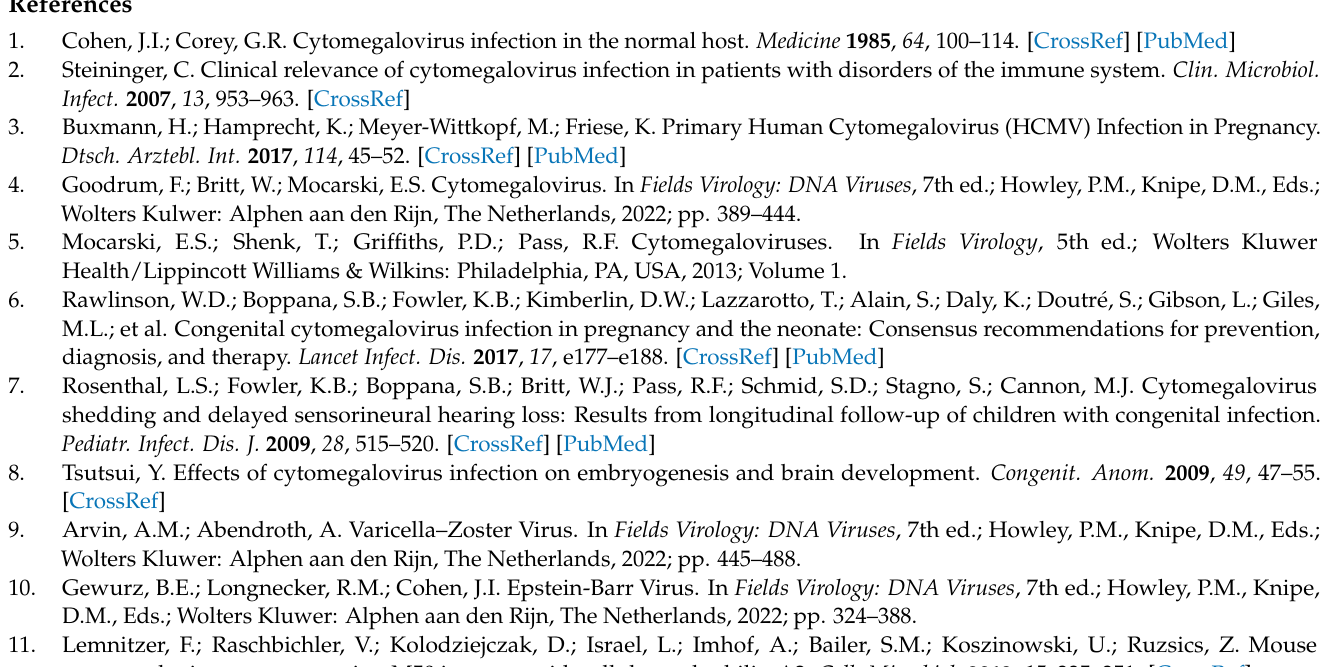
S2: Protein expression levels of HeLa and 293T cells given a s mean values ± SD signal-positive cells; Figure S1: Sequence alignment: Y2H data comparing the hook region of WT pUL53 and library clones derived from the primary screening of Lib1 with HCMV pUL50 referring to their shared-hook binding properties with three different groove proteins; Figure S2: Viral replication kinetics of HCMV ∆ UL53 and its revertant (HCMV Rev) determined by quantitation of GFP-positive cells and HCMV-specific qPCR on the different recombinant HFF